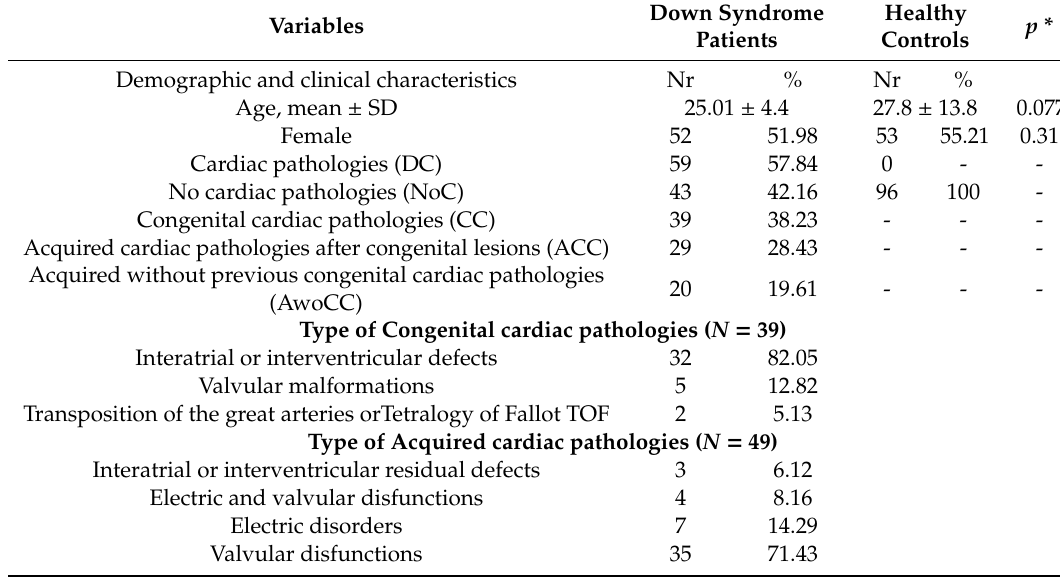
Table 1. Baseline characteristics of 102 adult young Down syndrome (DS) patients and 85 healthy controls.